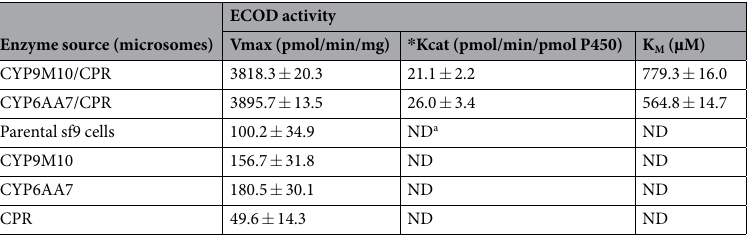
We further measured permethrin cytotoxicity in the presence of different concentrations of PBO, a P450 inhib- itor, showing that the percentage cell survival against permethrin cytotoxicity in CYP9M10/CPR co-expressing cells was significantly lower when the cells were co-treated with 200 µ M permethrin and 1 µ M or 10 µ M PBO (Fig. 2B). Under the same conditions, the Sf9 control cells showed no change in their permethrin cytotoxicity with PBO treatment (Fig. 2B). This not only indicates that the enhanced cell survival against permethrin cytotox- icity found in cells expressing CYP9M10/CPR was due to the activity of P450s, but also shows that cytotoxicity assays can be a good indicator in vitro for determining the ability of cells co-expressing P450/CPR to detox- ify insecticides. Similarly, the significant cell viability against the cytotoxic effects of permethrin in CYP6AA7/ CPR co-expressing cells demonstrates their enhanced tolerance to permethrin at concentrations of 50, 100, 200 and 400 µ M compared to the control cells (Fig. 2C). Taken together, these results suggest a significant role for CYP9M10/CPR and CYP6AA7/CPR in the detoxification of permethrin in insect cells. The results also show that the co-expression of P450/CPR in Sf9 cells detoxifies both PBOH and PBCHO, the metabolites of permethrin. Sf9 cells are very sensitive to PBOH and PBCHO at concentrations above 400 µ M (Fig. 3A). Not only were there significant improvements in cell viability against the cytotoxic effects of PBOH in CYP9M10/CPRand CYP6AA7/CPR co-expression cells observed at concentrations of 500 µ M and 700 µ M com- pared to Sf9 cells alone (Fig. 3A), but significantly higher cell viability against the cytotoxic effects of PBCHO in CYP9M10/CPR or CYP6AA7/CPR co-expression cells were also observed at concentrations of 62.5 µ M to 700 µ M compared to the control cells (Fig. 3B). These results indicate that CYP6AA7/CPR and CYP9M10/CPR may also play an important role in the metabolism of PBOH and PBCHO in insect cells.